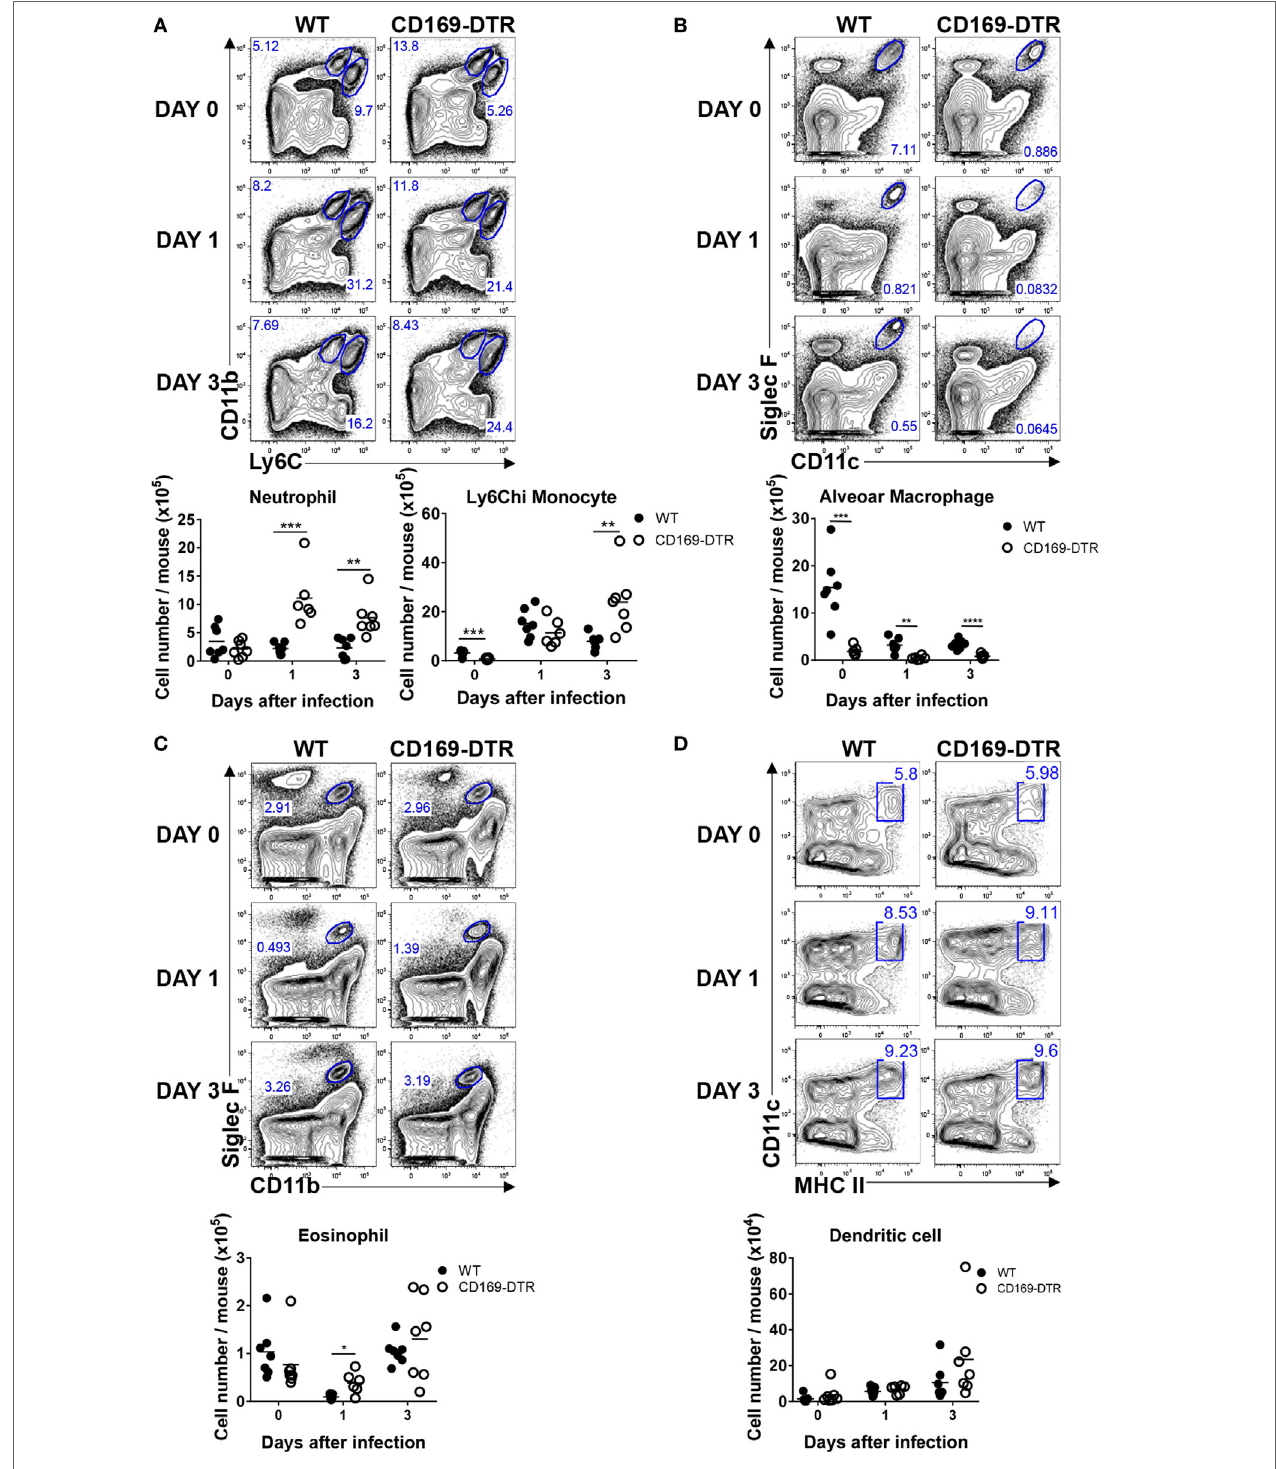
FigUre 3 | CD169 + cell depletion increases the lung recruitment of inflammatory cells during early respiratory syncytial virus (RSV) infection. At the indicated time points during RSV infection, the lungs of diphtheria toxin-treated wild-type (WT) and CD169-diphtheria toxin receptor (DTR) mice were collected, processed, and analyzed by flow cytometry. The numbers of monocytes and neutrophils (a) , alveolar macrophages (B) , eosinophils (c) , and dendritic cells (D) indicate the frequencies in gated cells. Cell number results are shown in the graphs; Each dot represents an individual mouse ( n = 7 in each group). Statistically significant differences between groups are indicated: * P < 0.05, ** P < 0.01, *** P < 0.001, and **** P < 0.0001. Data are representative of two independent